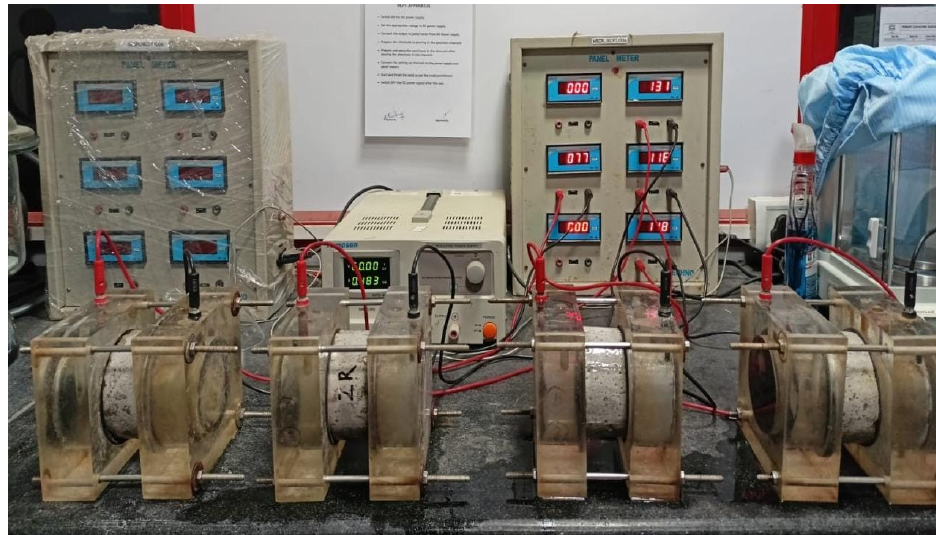
Figure 13. Rapid chloride permeability test setup.